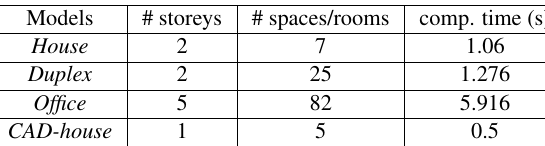
Table 1: Characteristics of the test models set of 3 IFC model and 1 CAD.